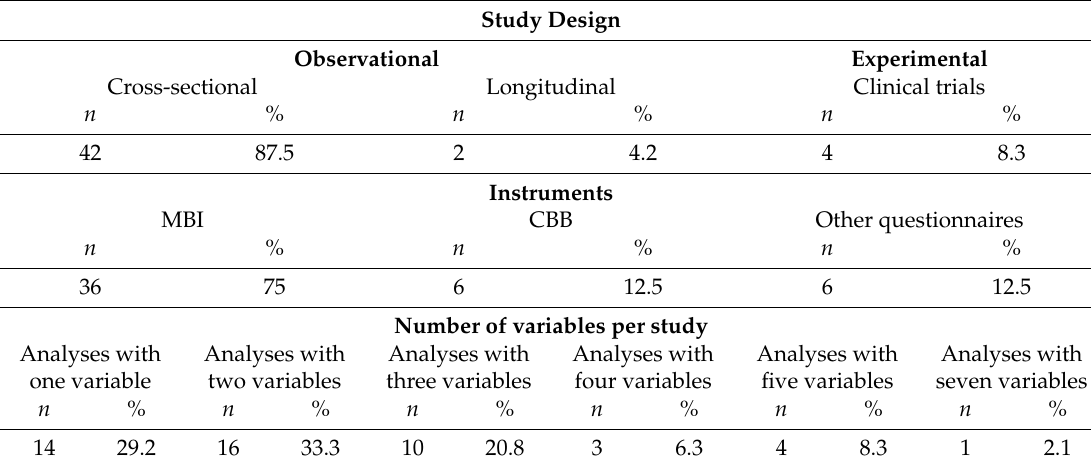
Table 4. Type of studies and instruments with samples of